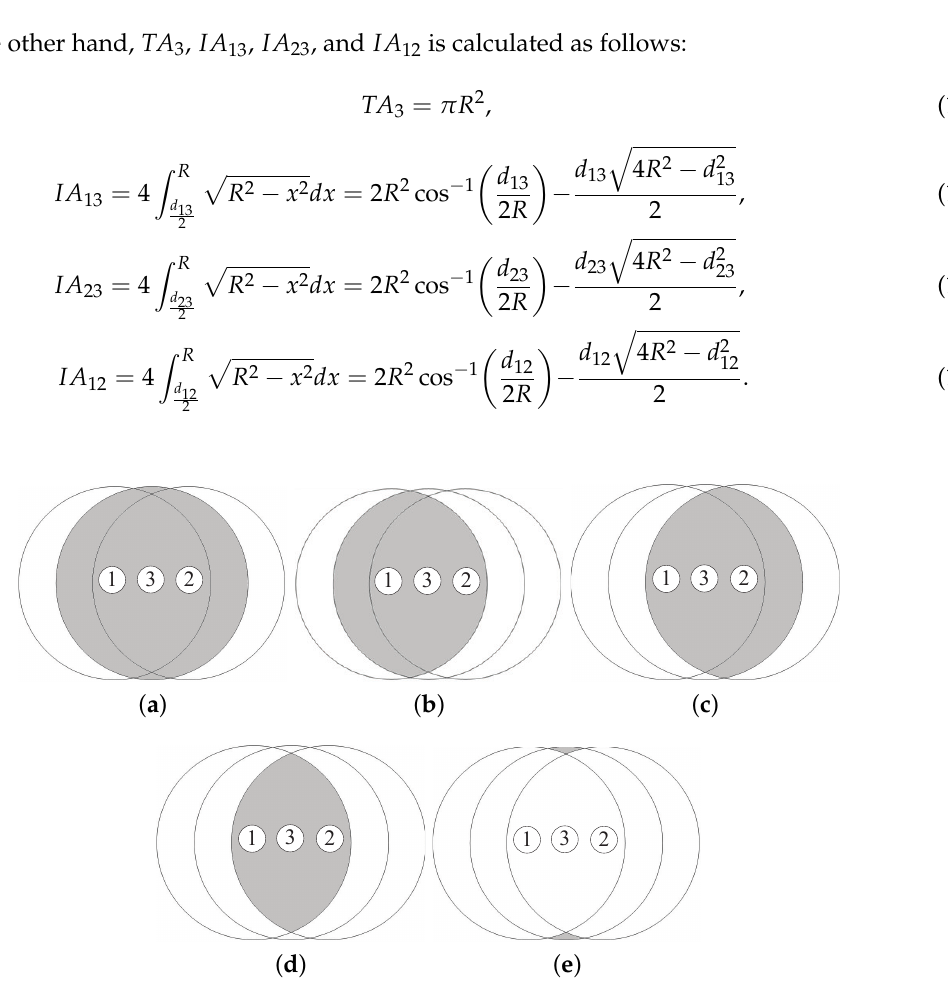
Figure 7. The additional coverage area of node 3 in case 1. ( a ) TA 3 ; ( b ) IA 13 ; ( c ) IA 23 ; ( d ) IA 12 ; ( e ) AC 1